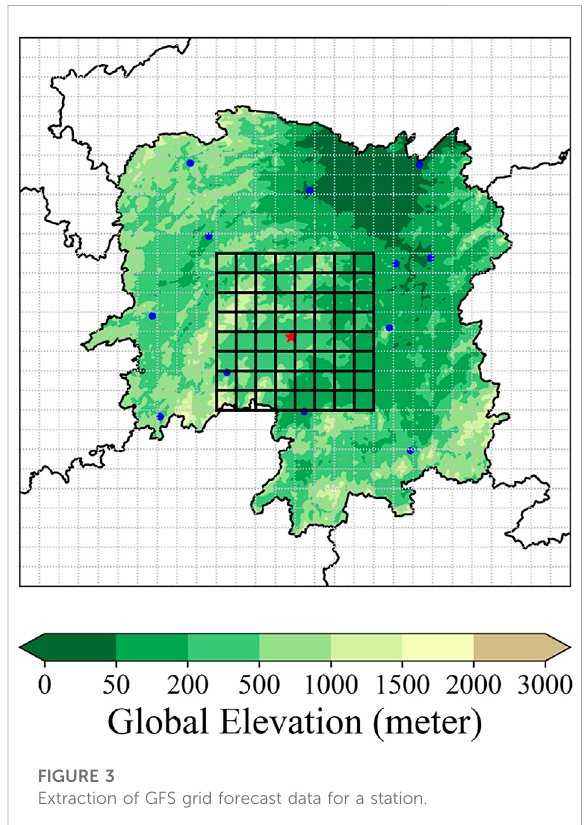
FIGURE 3 Extraction of GFS grid forecast data for a station.